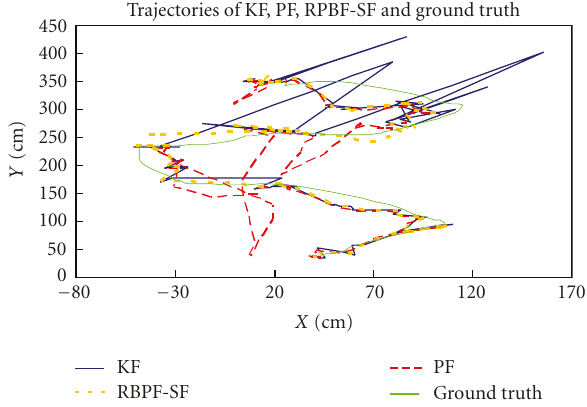
Figure 12: Tracking trajectories of KF, PF, RBPF-SF, and ground truth in the 1st experiment.